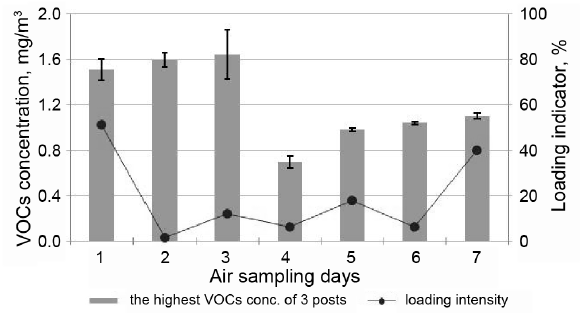
Fig. 5. Dispersion of VOCs concentration and loading indicator in autumn